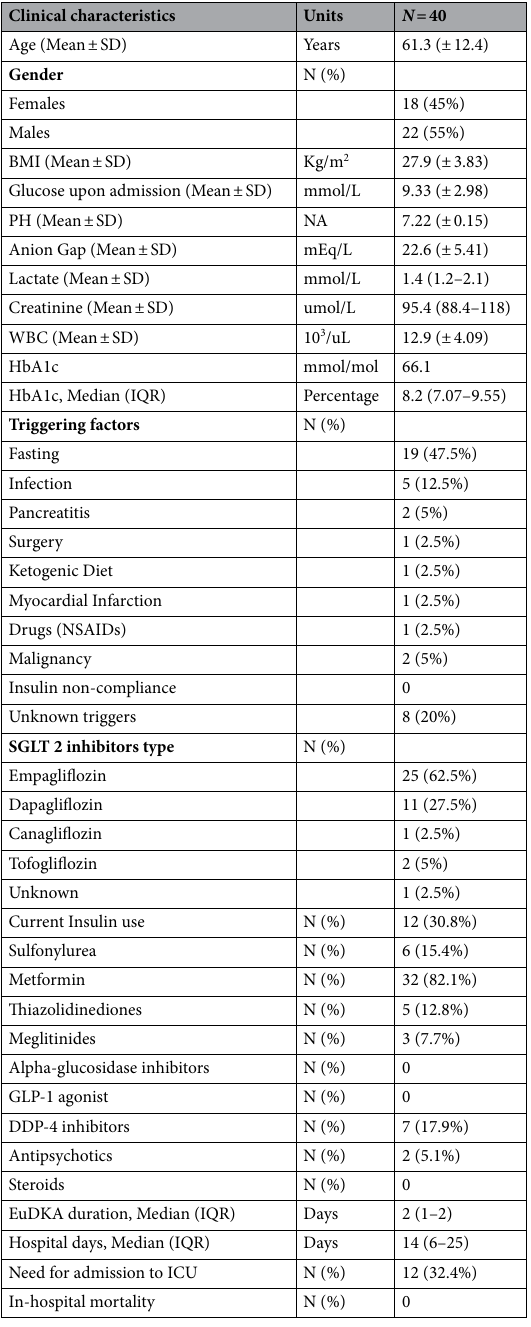
Table 3. Literature review of last 30 reported cases of EuDKA in type 2 diabetes mellitus patients on